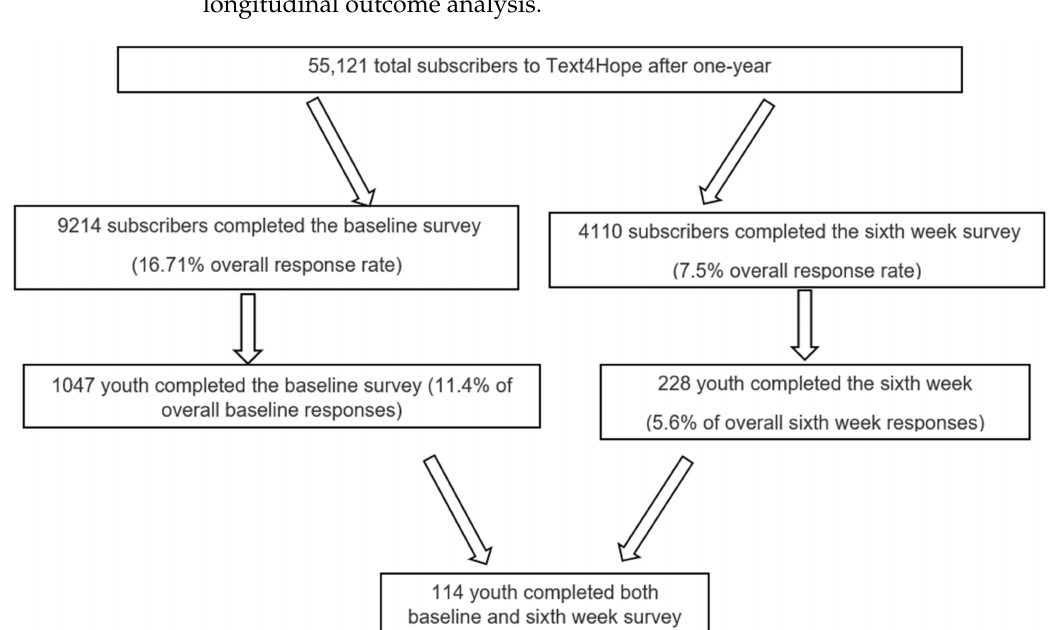
Figure 1. Study flow chart.